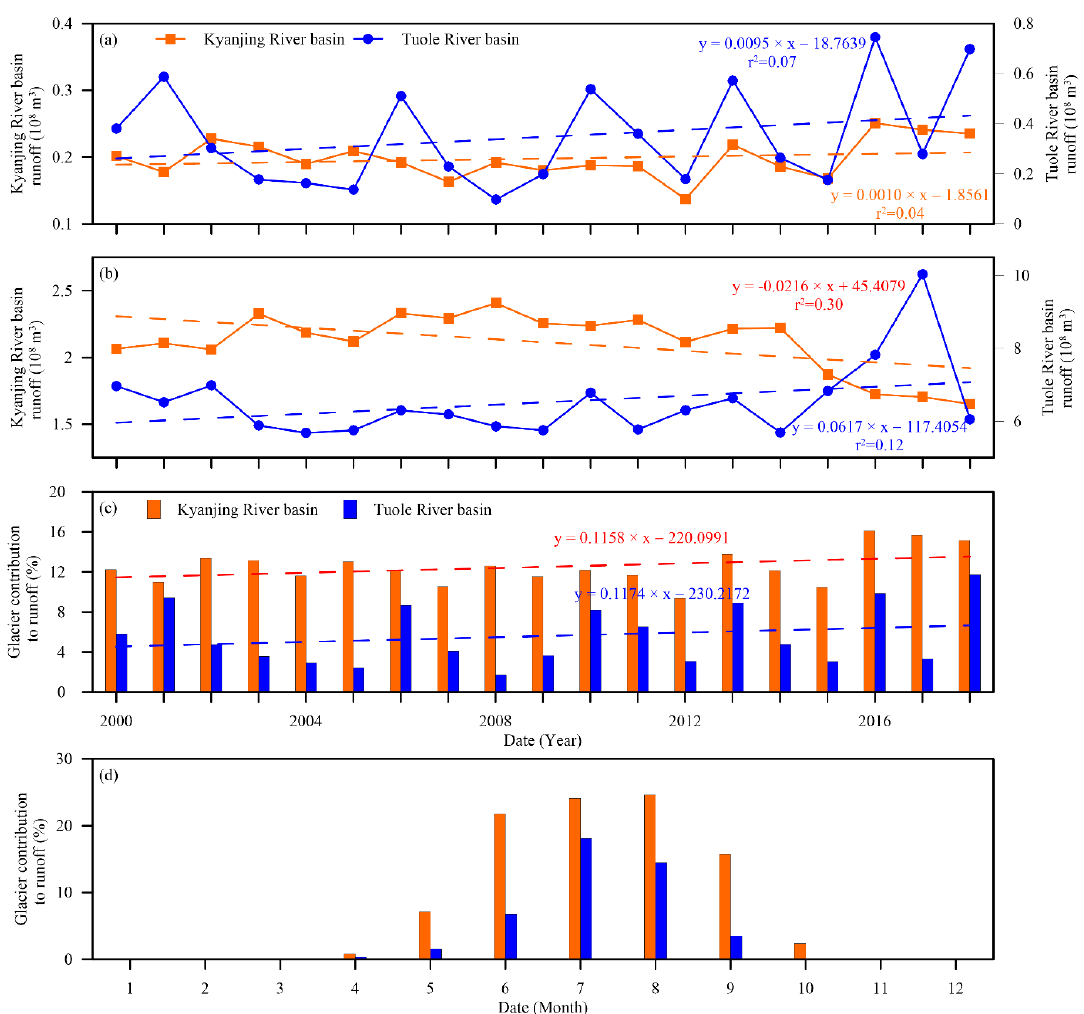
Figure 4. Comparison between annual glacier meltwater ( a ) and runoff ( b ) from the Kyanjing basin and the Touhe River basin; the annual ( c ) and the monthly ( d ) contribution of meltwater from the glacier region to the runoff of the Kyanjing basin and the Tuole River basin.